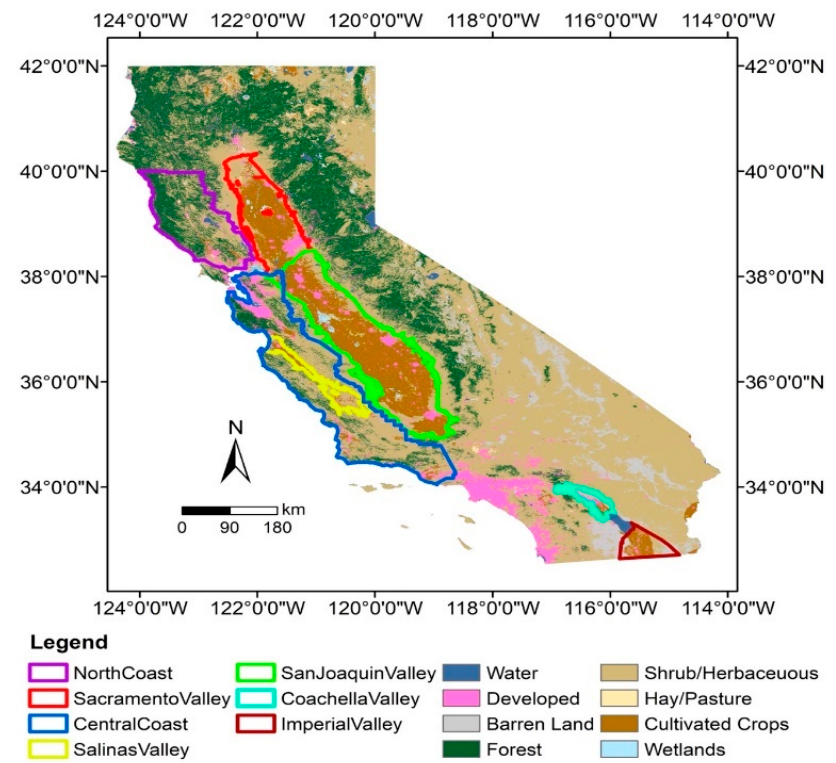
Figure 1. Fruits, nuts, and vegetables are largely grown across 7 geographic regions within California. While agricultural valleys are responsible for most production, the north and central coast regions are known for winegrape production. Basemap data are from the 2016 NLCD [52].